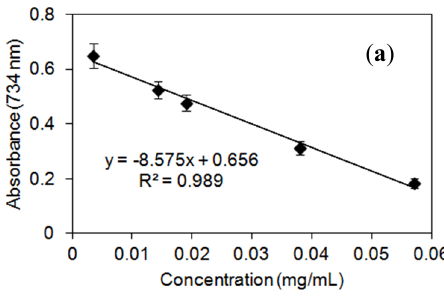
Figure 4. Antioxidant activities of Cs-GP1: ( a ) Scavenging (eliminating) ABTS •+ radicals; ( b ) Ferric reducing power (FRAP); ( c ) Protecting against H 2 O 2 -inducd viability loss of PC12 cells (exposed to 80 μ M H 2 O 2 for 1 h; * significant effect at p <